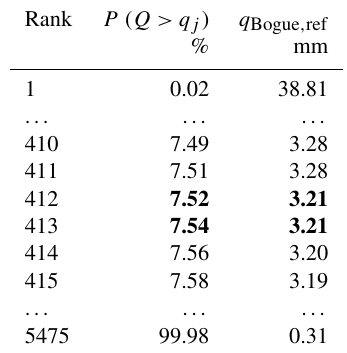
Table A3. The (bold) percentiles identified in Table A2 are used here to retrieve the corresponding streamflow values gauged during the donor years (i.e., 1948–1963) at the target basin (i.e., Bogue River, LA). Percentiles and the corresponding streamflow values are in bold.